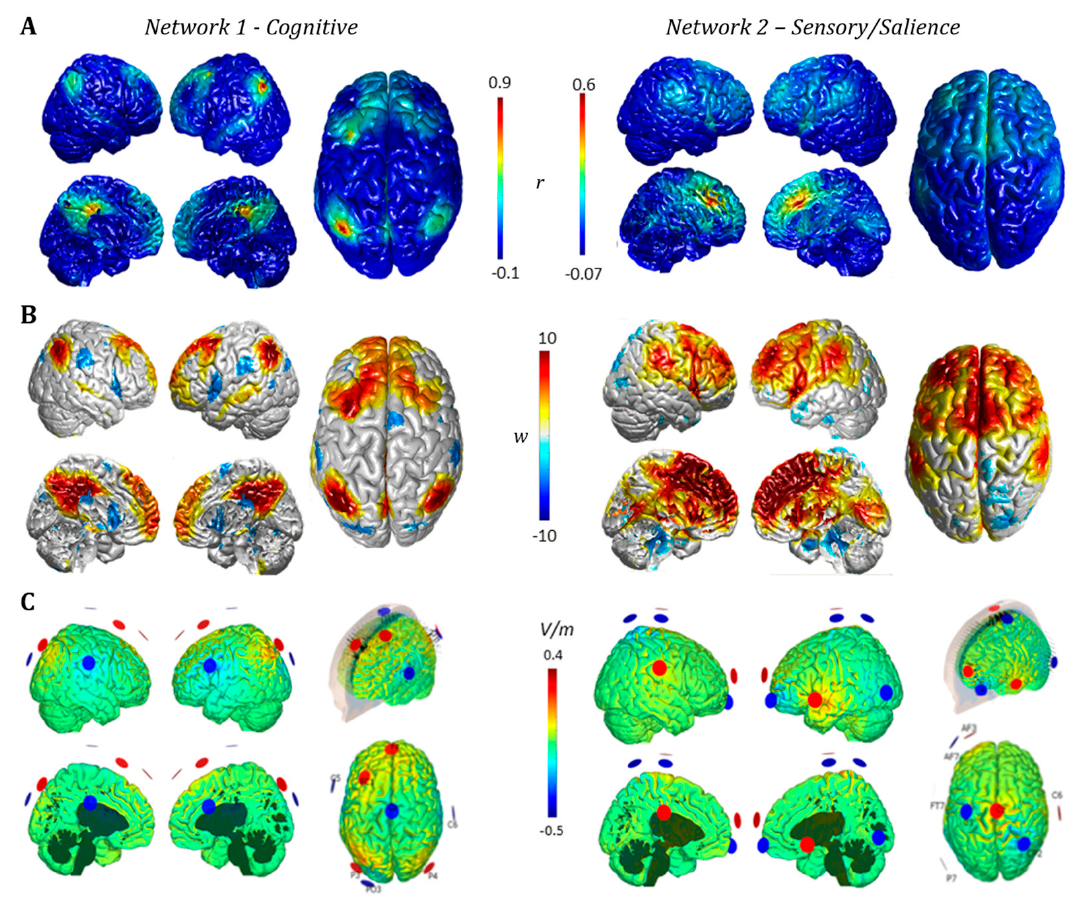
Figure 9. Multichannel transcranial electrical stimulation (tES) optimized montages. ( A ) Functional connectivity profile for Network #1 and #2, mapped onto the cortical surface. ( B ) Weighted target maps for both networks. The values in the scale correspond to the weights multiplied by the sign of E ntarget to display excitatory and inhibitory areas. For Network #1, correlations higher than 0.4 were assigned to excitation with maximum weight w max = 10, whereas lower than − 0.06 were assigned inhibition with lower negative weight w min = 5. For Network #2, the threshold value for excitation was set to 0.15 and for inhibition to − 0.04. ( C ) Optimized montages for Networks #1 and #2. Both solutions involve 8 electrodes, delivering a total maximum current of 4 mA. Anodes are shown in red, cathodes in blue; arrows represent current density.